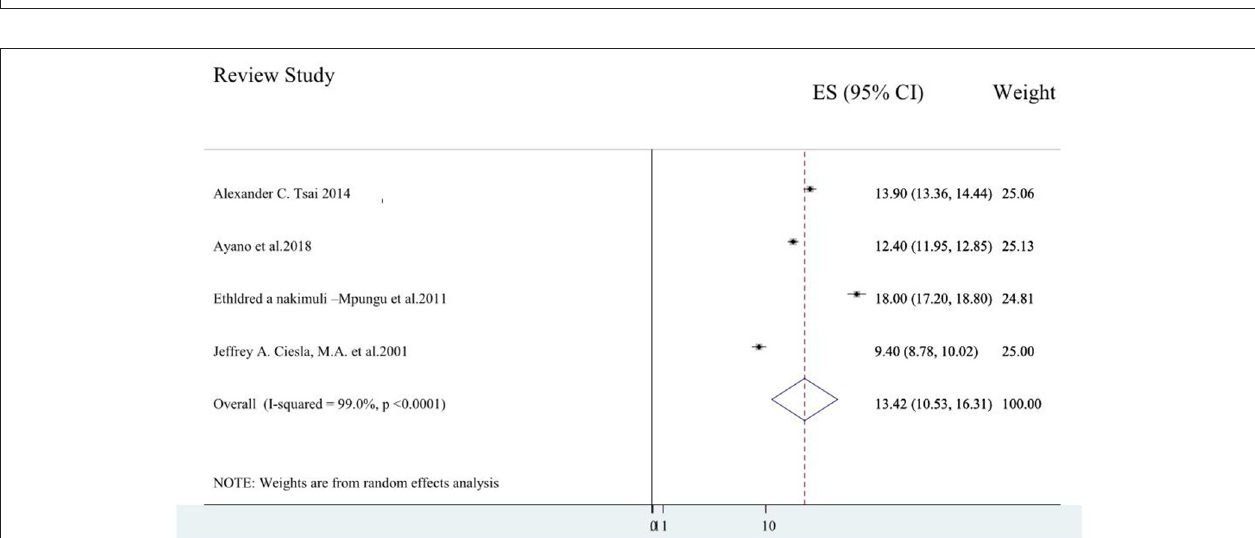
FIGURE 2 | A forest plot for the systematic review of reviews on depressive symptoms.